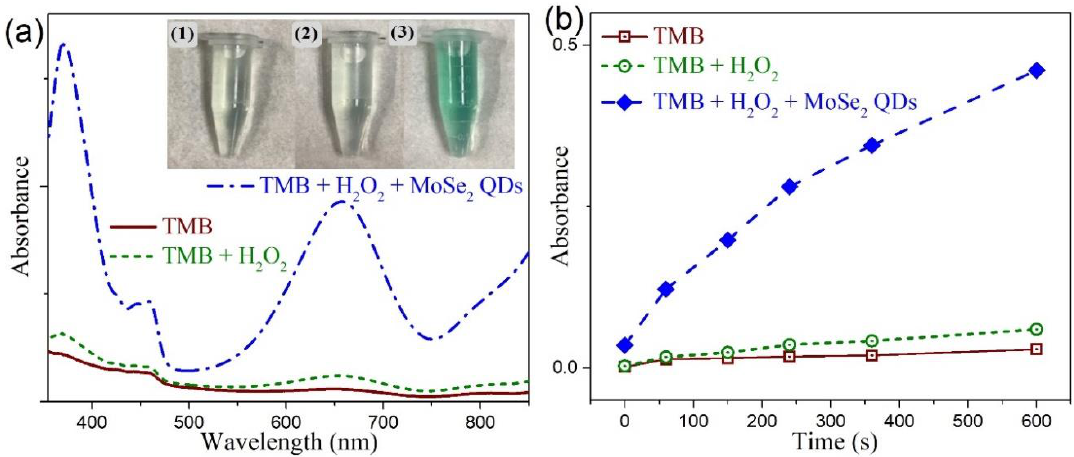
Figure 8. ( a ) UV-visible absorption spectra of (1) 3,3,5,5-tetramethylbenzidine (TMB) solution (brown); (2) TMB–H 2 O 2 system (green); (3) TMB–H 2 O 2 –MoSe 2 QDs system (blue). Inset: the corresponding photographs of these reaction systems. ( b ) The time-dependent absorbance changes at 652 nm of these systems.